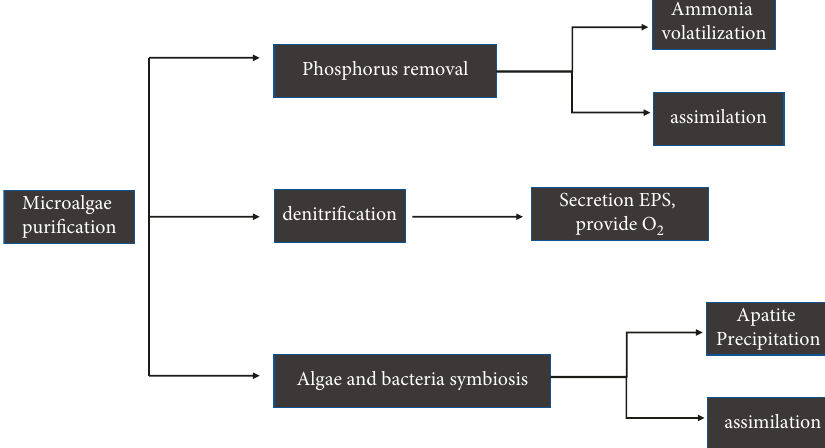
Figure 6: The work path of microalgae in wastewater